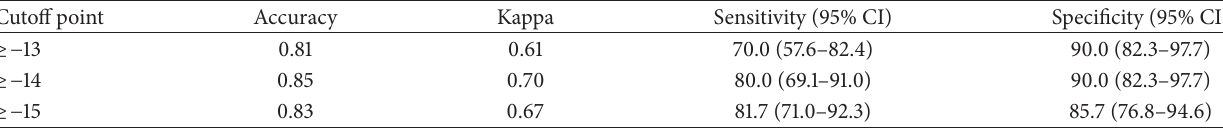
Table 3: Sensitivity, specificity, and validity indices and cutoff values for LARS with respect to the clinical diagnostic of apathy performed by the main researcher.